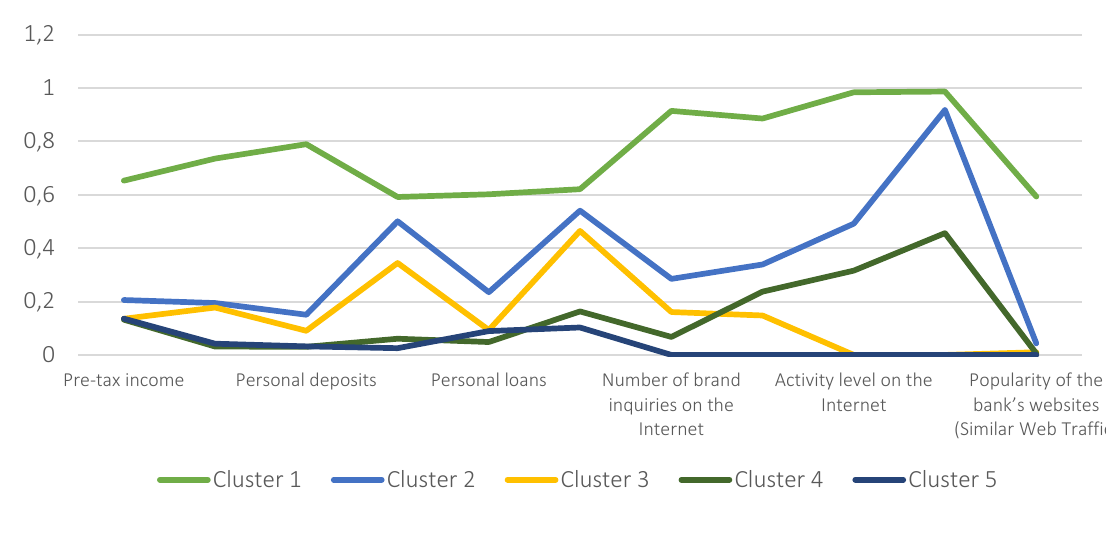
Figure 2. Graphical interpretation of the bank cluster characteristics by the competitive capacity level